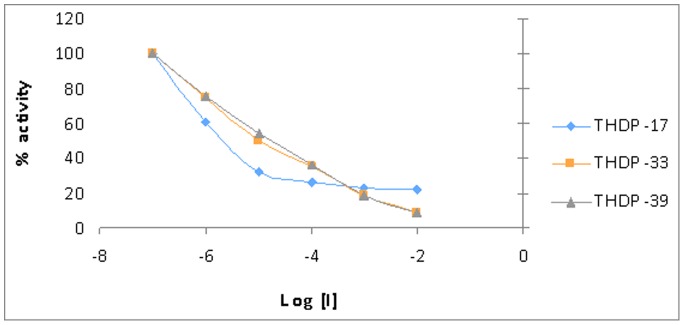
Inhibitory effect on glutaminase activity of several compounds tested in this study.Data are shown in log scale (inhibitor concentration), being 100% activity measured without inhibitor. There was not significant differences among compounds tested (Student t test; p>0.05). THDP-17 was chosen on toxic effect base.